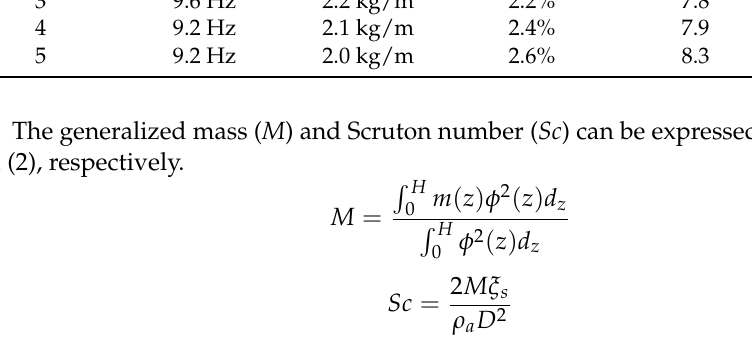
models. Take Case 1 as an example: Figure 5a shows the time history of free vibration displacement obtained by a repeated hammering test. The attenuation time histories of other cases can be obtained by the same method. The time histories of normalized